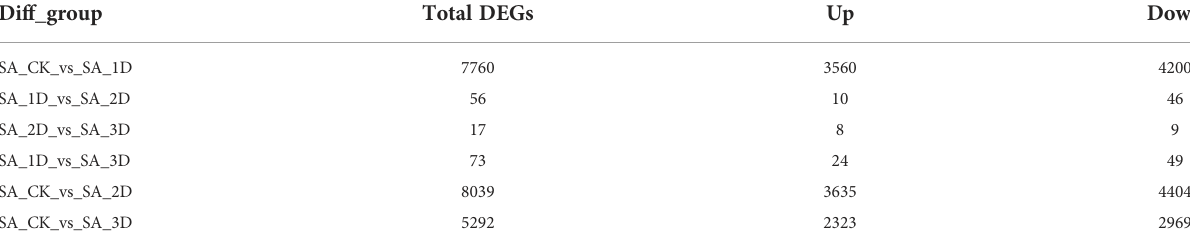
TABLE 6 Statistics on the number of DEGs between samples under SA stress